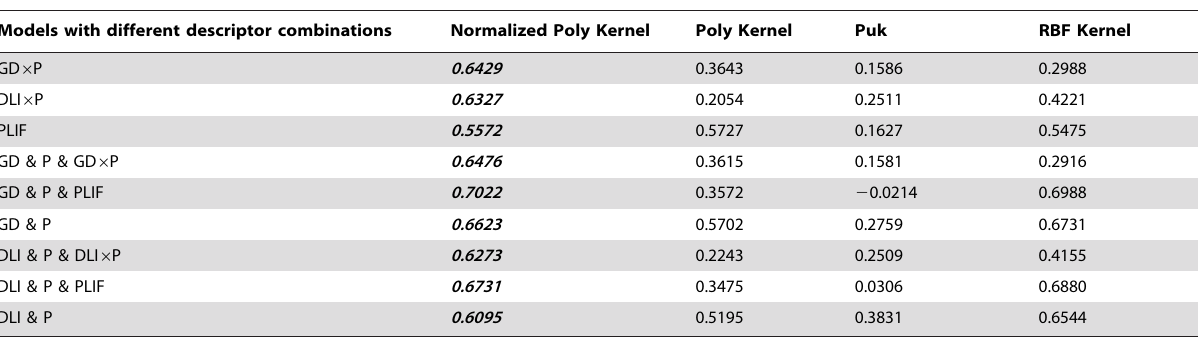
Table 1. Q 2 CV of each model with different combinations of descriptor blocks.